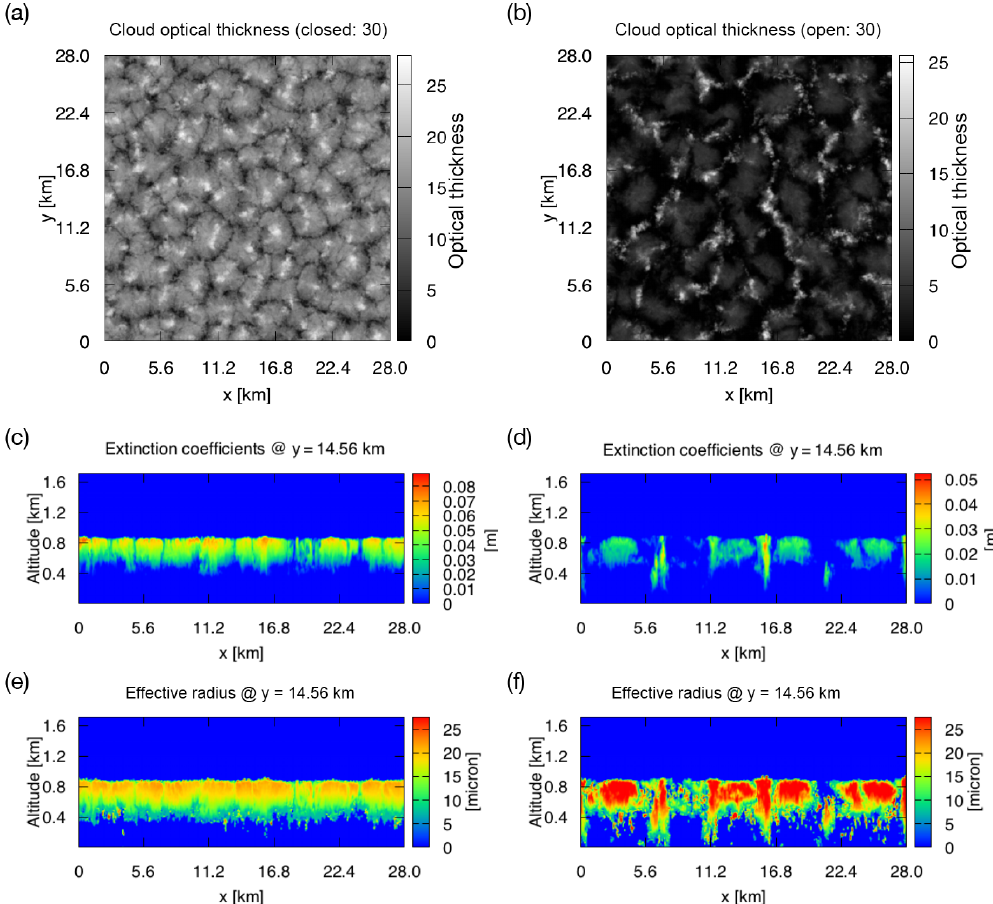
Figure 1. Examples of cloud properties in (a, c, e) closed-cell and (b, d, f) open-cell cases, taken from the 30th timestep of SCALE-LES simulation data. (a, b) Horizontal distributions of COT, (c, d) vertical cross sections of extinction coefficients, and (e, f) vertical cross sections of